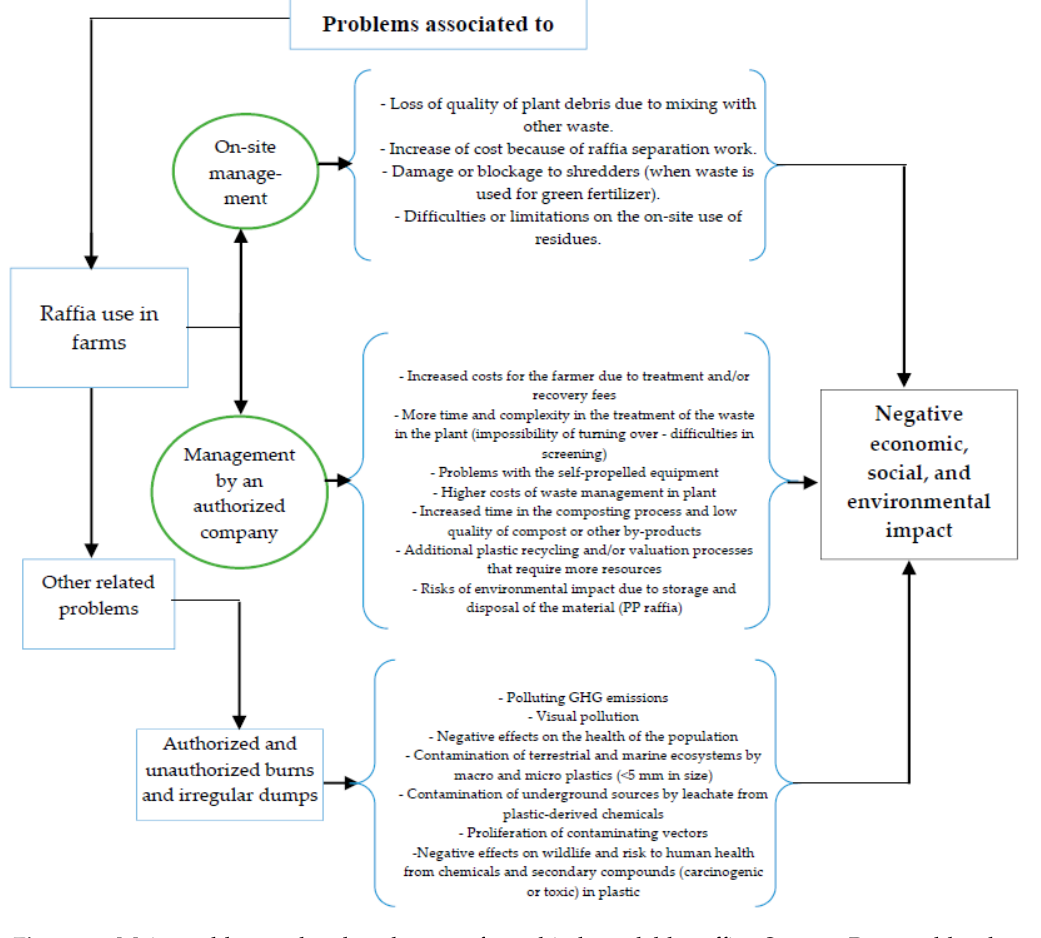
Figure 3. Main problems related to the use of non-biodegradable ra ffi a. Source: Prepared by the authors from